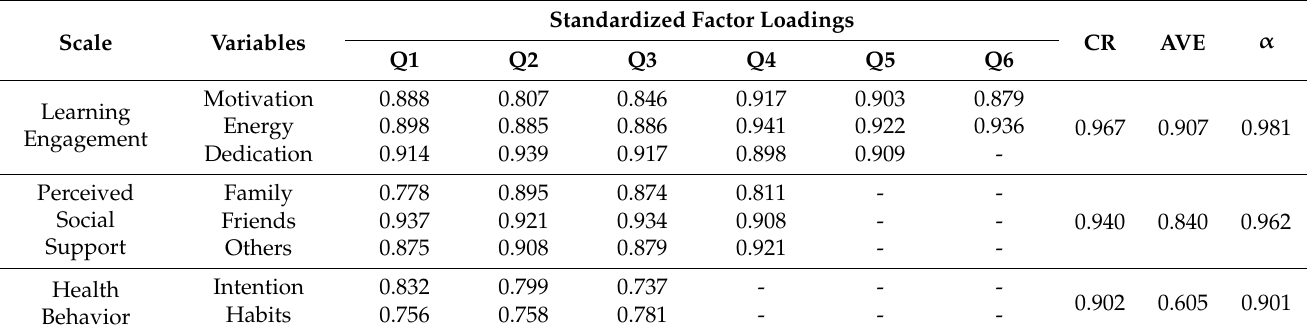
Table 2. Scale reliability and convergent validity analysis.